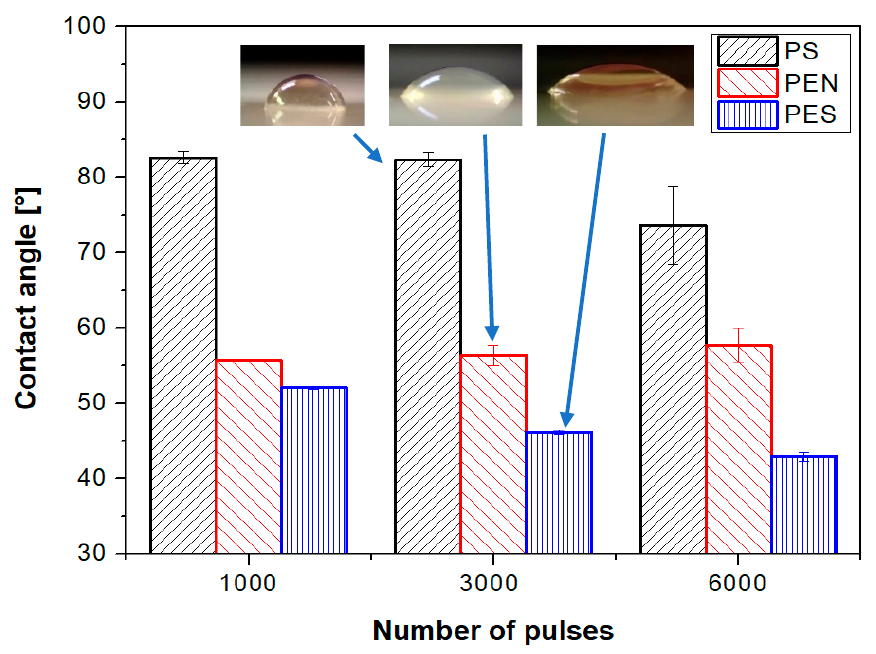
Figure 6. Contact angles of laser-treated polystyrene, polyethylene naphthalate, and polyethersulfone. The laser exposure of 10 mJ·cm − 2 with 1000, 3000, and 6000 pulses was applied.